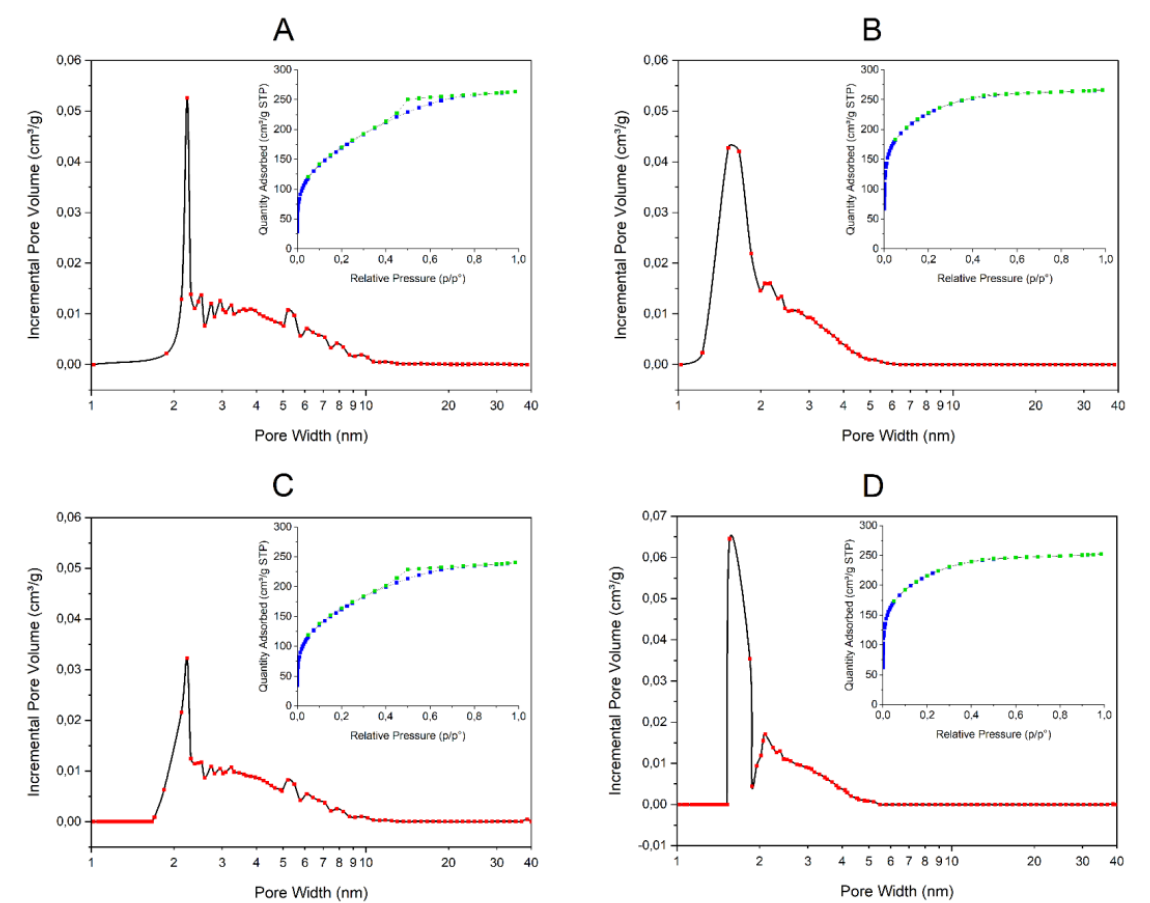
Figure 4. Pore size distribution curves and nitrogen adsorption − desorption isotherms (inserts) of silica composites: ( A ) X1 (with both β -galactosidase and PDMS); ( B ) X2 (with β -galactosidase and without PDMS); ( C ) X3 (without β -galactosidase and with PDMS); ( D ) X4 (without both β - galactosidase and PDMS).